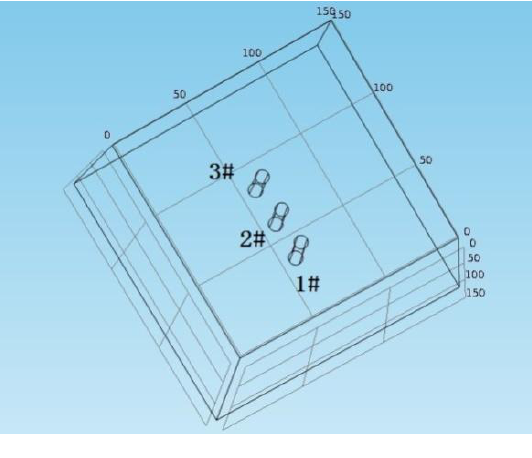
Figure 8. Finite element model